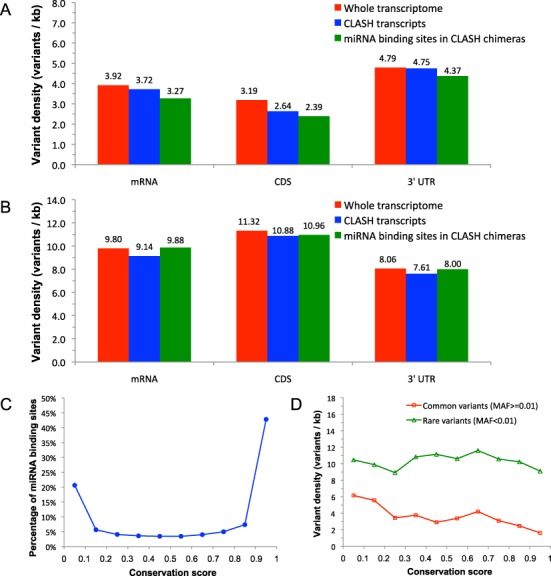
Variant densities in whole transcriptome, CLASH transcripts and miRNA binding sites for (A) common variants (MAF ≥ 1%); (B) rare variants (MAF <1%); (C) percentages of miRNA binding sites by evolutionary conservation levels; (D) density of variants (common or rare) with different MAF thresholds for miRNA binding sites grouped by conservation level.